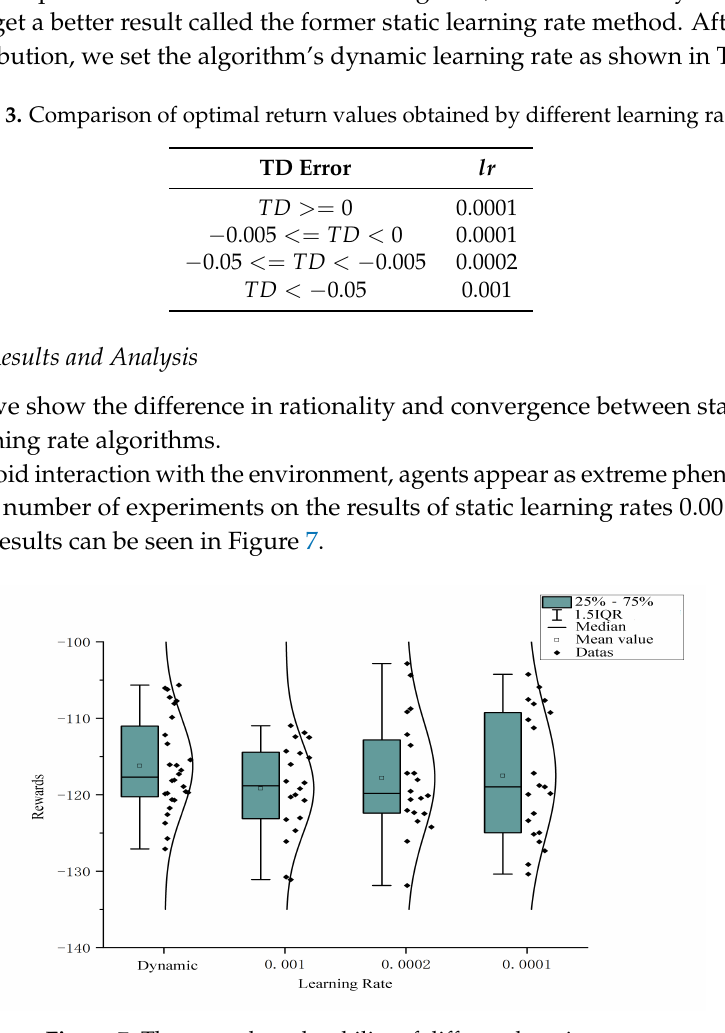
Figure 7. The rewards and stability of different learning